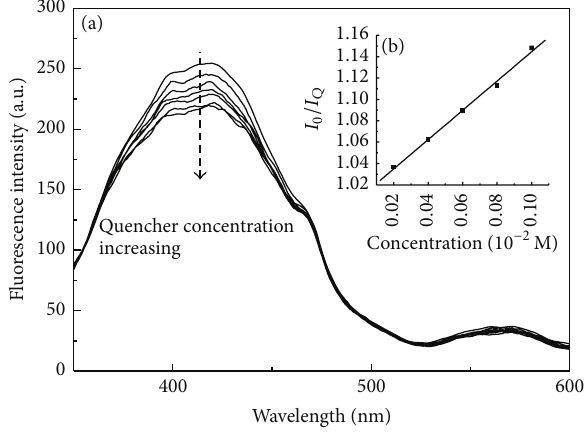
Figure 10: (a) Fluorescent spectra of WPU-CFBB emulsion in increasing quencher concentration of hydroquinone under 325 nm excitation; (b) the plot of 𝐼 0 /𝐼 𝑄 versus the concentration of hydro- quinone [ 𝑄